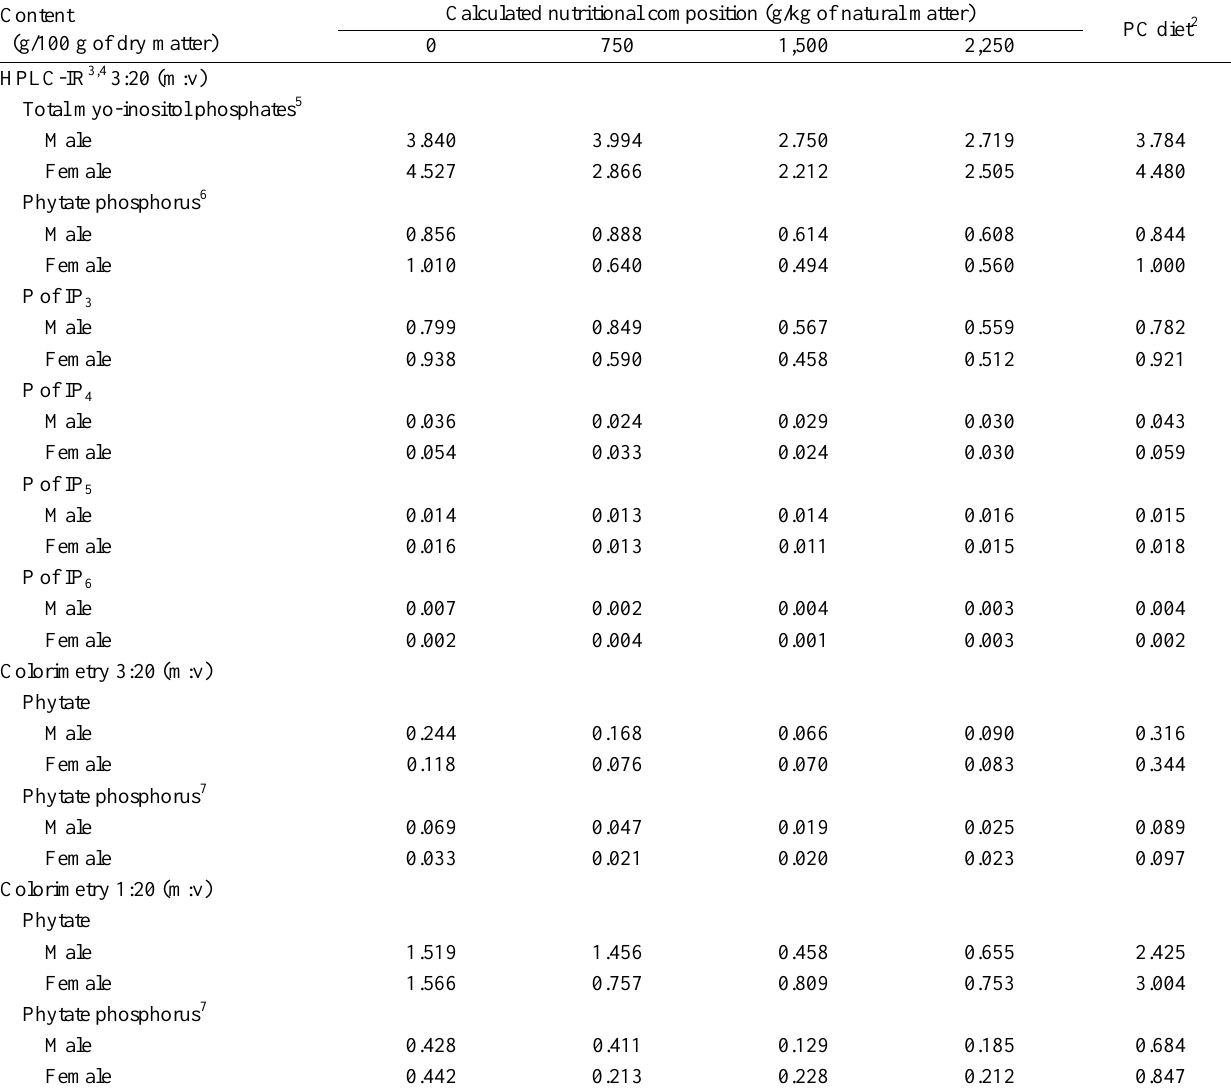
Table 3. Contents of phytate and phytate phosphorus (P phy ) in excreta from male and female broilers, determined according to two analytical methodologies and extraction